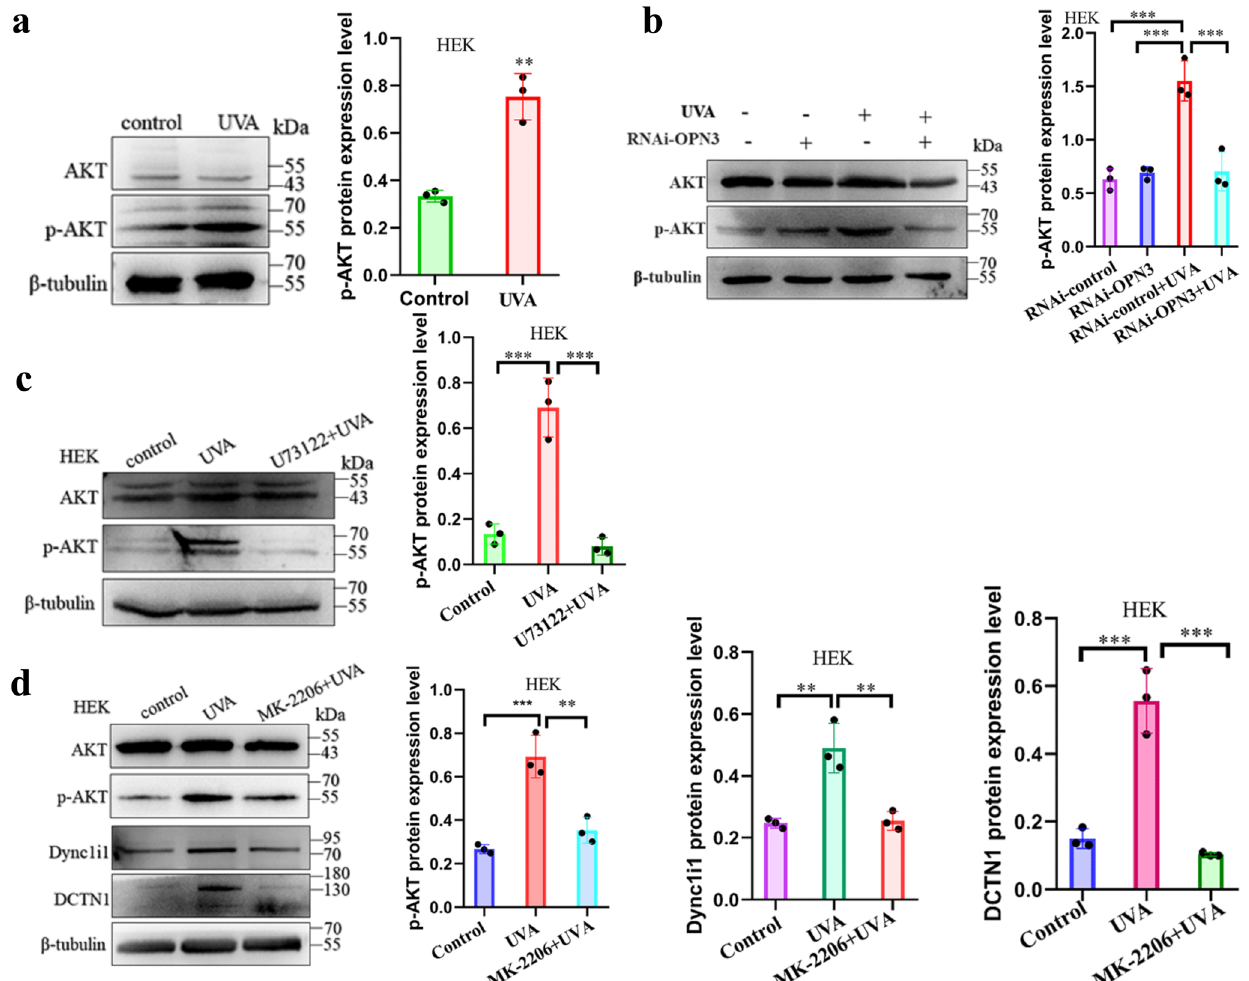
Fig. 7 OPN3 regulates the expression of Dync1i1 and DCTN1 via the AKT signaling pathway. a Cells were irradiated without and with UVA, and AKT protein and phosphorylated-AKT (p-AKT) protein levels were determined by WB. β -tubulin was used as a loading control. The relative protein level was quanti fi ed using Quantity One software. Statistical signi fi cance was determined by t -test analysis. ** P < 0.01. b HEK were transfected with siRNA against OPN3 irradiated with UVA and lysed after 1 h. Lysates were analyzed by WB using the indicated antibodies (anti-OPN3, anti-AKT, anti-p-AKT, anti-Dync1i1, and anti-DCTN1). β -tubulin was used as a loading control. The relative protein level was quanti fi ed using Quantity One software. Statistical signi fi cance was determined by one-ANOVA with post-test. *** P < 0.001. c HEK treated with U73122 were stimulated with 3 J/cm 2 UVA, and protein lysate was analyzed by WB. β -tubulin was used as a loading control. The relative protein level was quanti fi ed using Quantity One software. Statistical signi fi cance was determined by one-ANOVA with post-test. *** P < 0.001. d HEK treated with MK-2206 (2HCl) were stimulated with 3 J cm − 2 UVA, and protein lysate was analyzed by WB. β -tubulin was used as a loading control. The relative protein level was quanti fi ed using Quantity One software. Statistical signi fi cance was determined by one-ANOVA with post-test. ** P < 0.01, *** P <